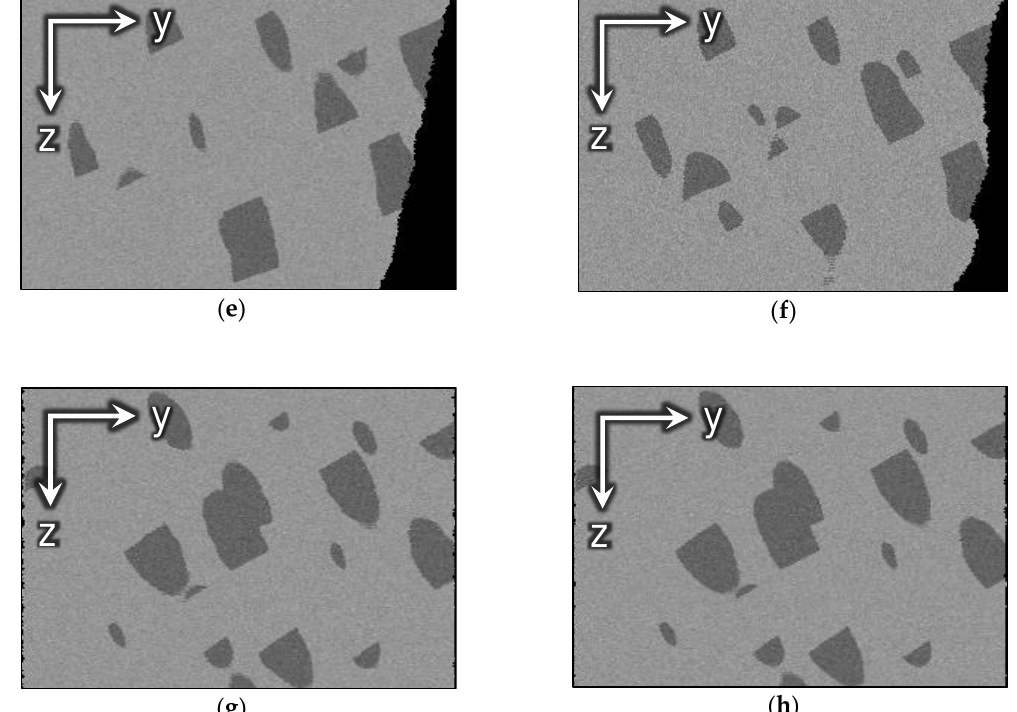
Figure 14. The side view of the synthetic sample: ( a ) GT; ( b ) aligned with SAD; ( c ) aligned with StackReg; ( d ) aligned with ImageStabilizer; ( e ) aligned with JavaSIFT; ( f ) aligned with Elastic; ( g ) aligned with the proposed algorithm based on SAD; ( h ) aligned with the proposed algorithm based on subpixel JavaSIFT.